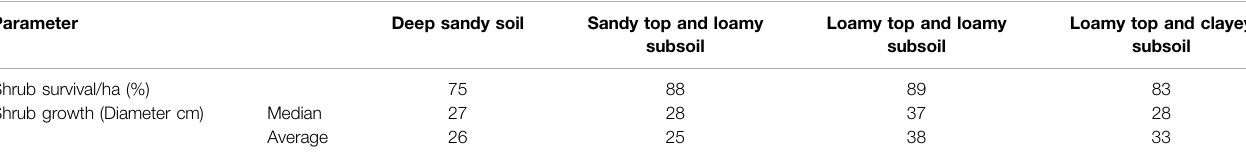
TABLE 5 | Leptospermum nitens performance in different soil